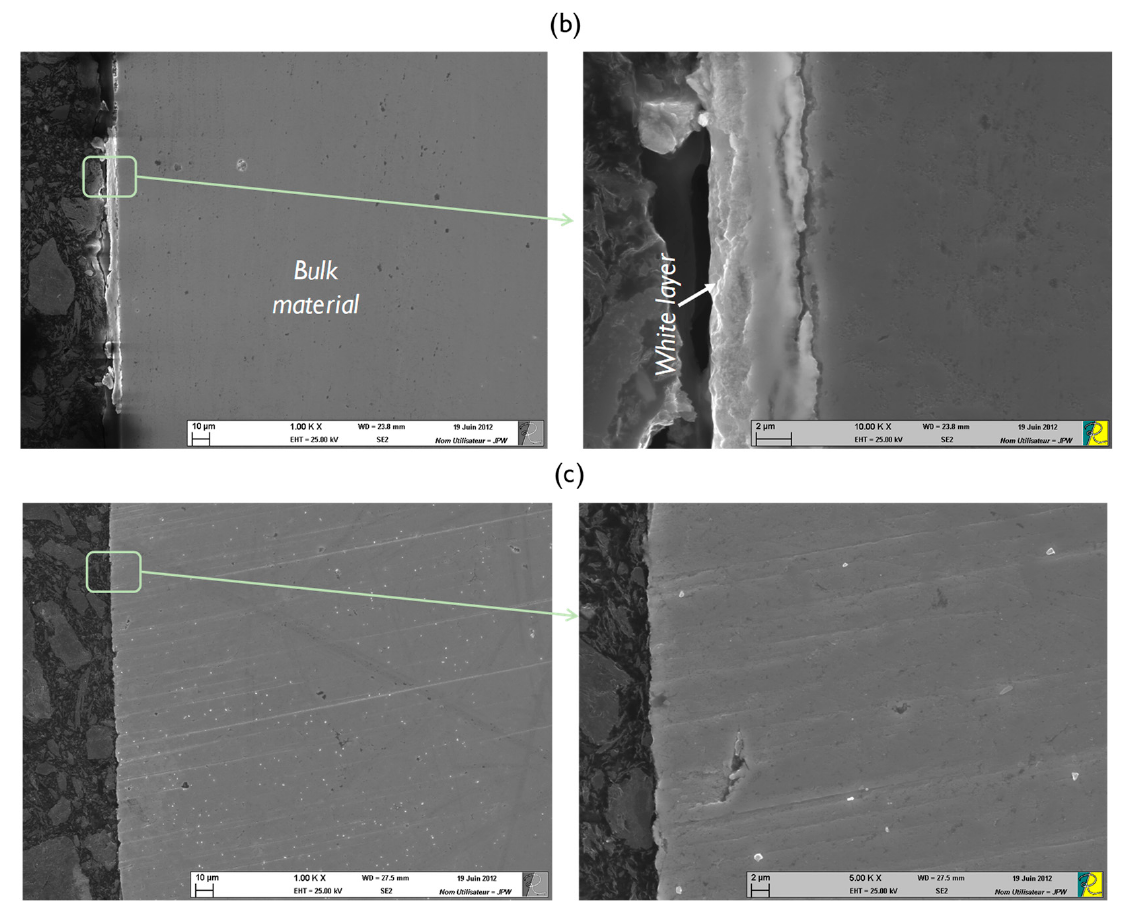
Figure 6. Micrographs of AISI 52100 steel after ( a ) precision hard turning, ( b ) grinding, and ( c ) sequential grinding and honing.